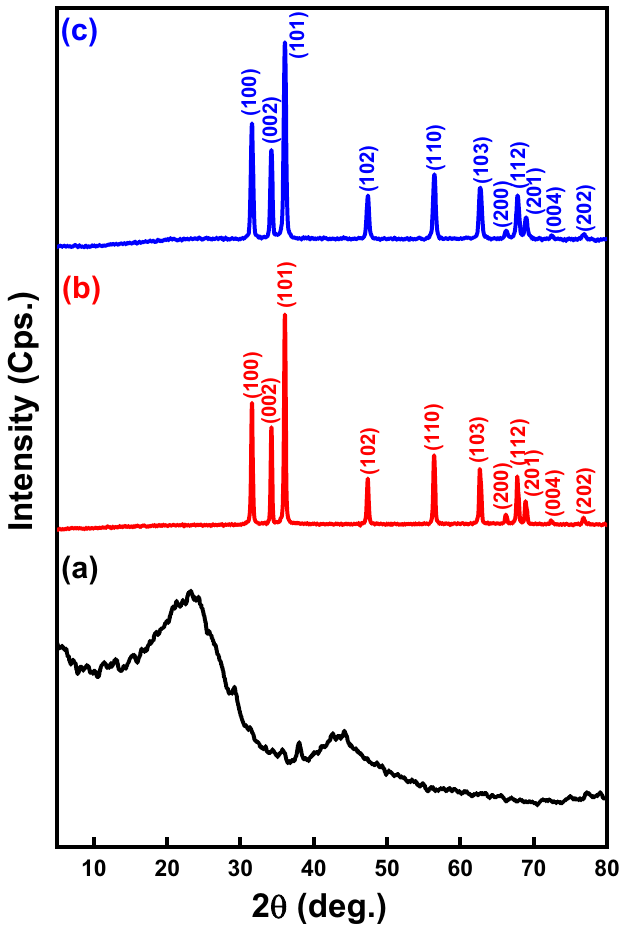
Figure 4. XRD patterns of ( a ) AC, ( b ) ZnO NPs, and ( c ) (Z3C1)